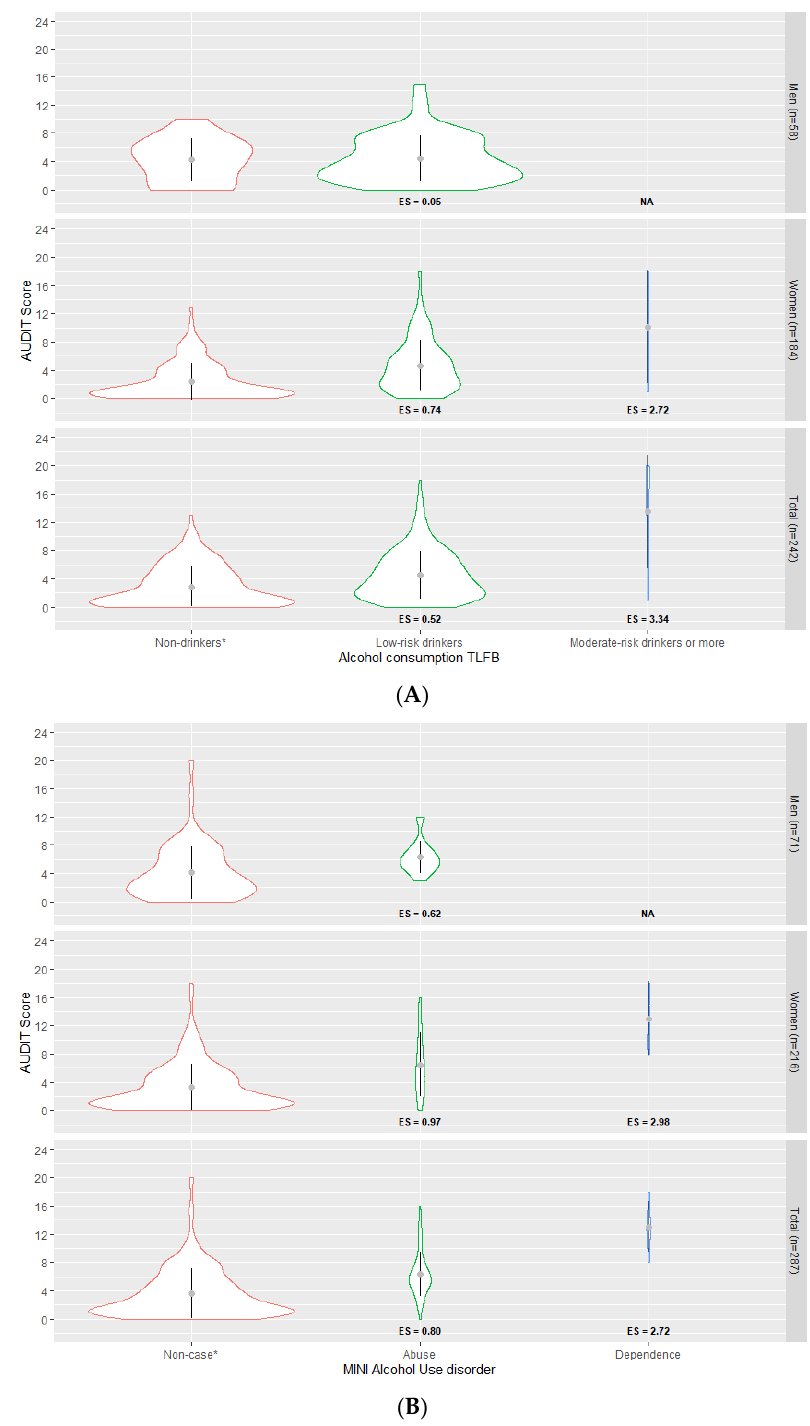
Figure 2. ( A ) AUDIT online mean scores (standard deviation) and effect size, by alcohol consumption categories (TLFB) ( n = 242). Weighted values. AUDIT: Alcohol Use Disorders Identification Test; TLFB: Timeline Followback; ES: effect size.